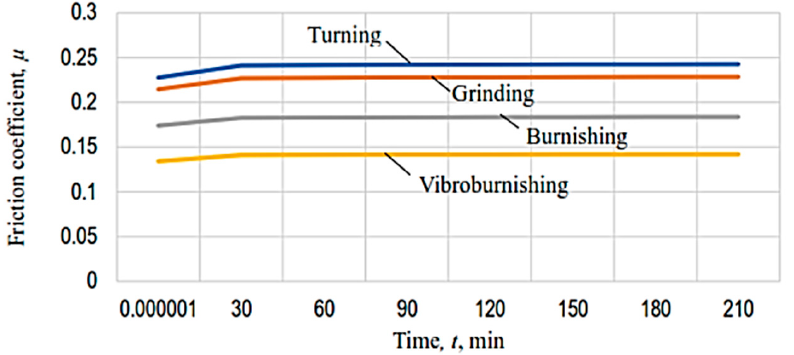
Figure 10. The influence exerted by the process duration on the value of the friction coefficient µ for different machining processes applied to the tested surface ( p = 70,000 Pa).